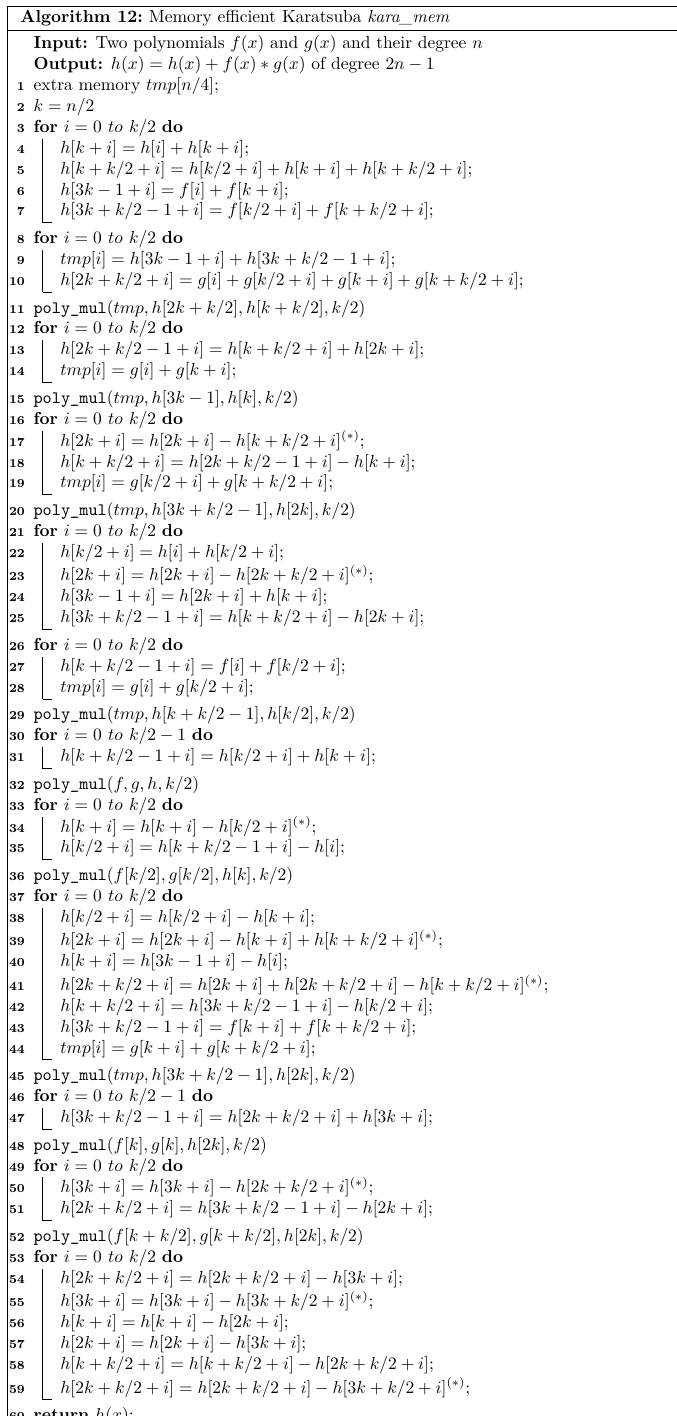
Algorithm 12: Memory efficient Karatsuba